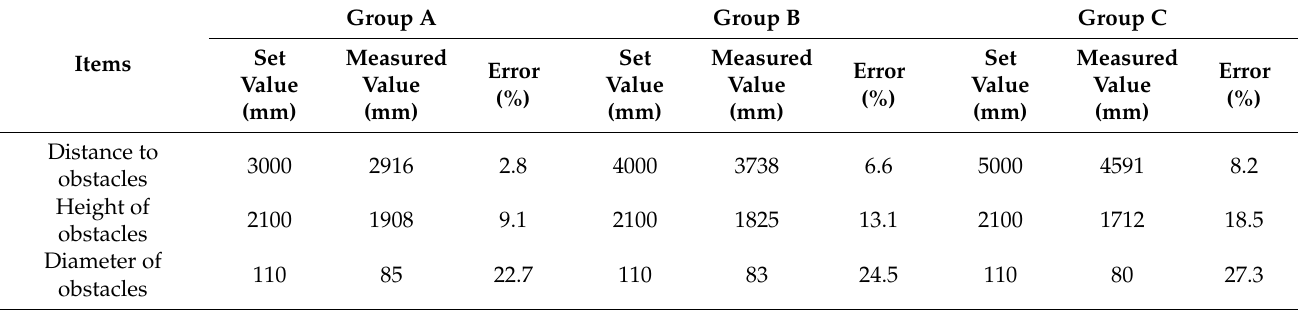
Figure 8. Validation experiment. Table 4. Results of validation